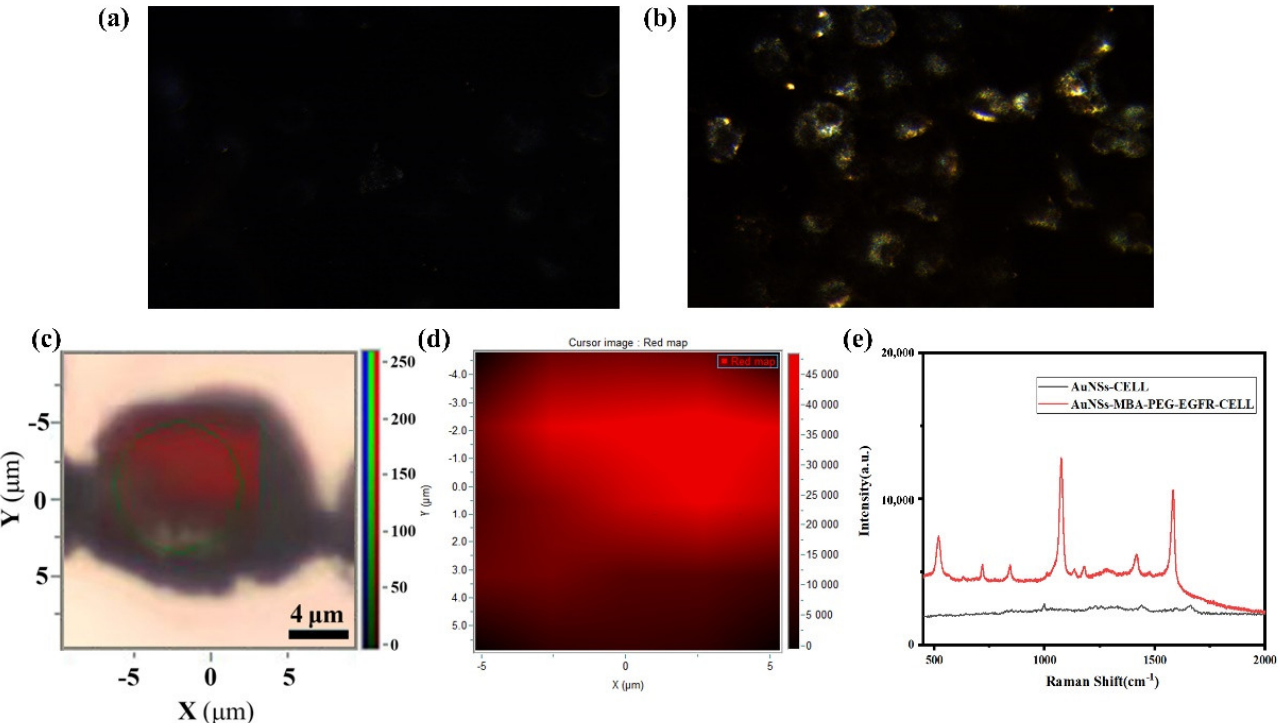
Figure 5. Dark field imaging and SERS imaging of A549 cells. ( a ) Dark field imaging of AuNSs. ( b ) Dark field imaging of EGFR − PEG − 4 − MBA − labeled AuNSs used the Raman chip. ( c ) Raman mapping of EGFR − PEG − 4 − MBA − labeled AuNSs. ( d ) The color diagram of the Raman signal intensity. ( e ) Raman data diagram of AuNSs and EGFR − PEG − 4 − MBA − labeled AuNSs with A549 cells.